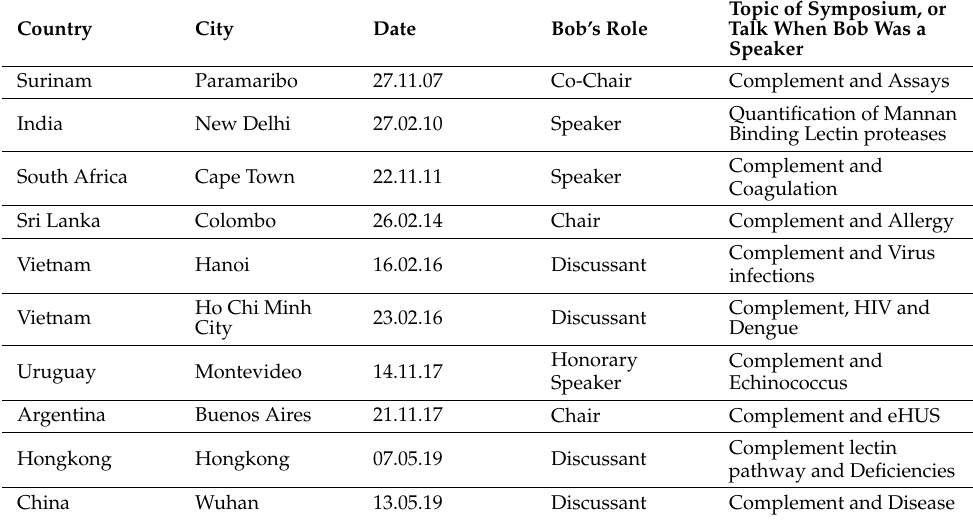
Figure 1. The EU complement consortium (picture taken at the teaching and research symposium in New Delhi, 27.02.10), from left to right, Yngve Sommarin (Lund), Franco Tedesco (Trieste), Jörgen Wieslander (Lund), Lennart Truedsson (Lund), Reinhard Würzner (Innsbruck), Narinda Mehra (AIIMS, New Delhi, host of symposium), Peter Garred (Copenhagen), Mac Turner (London), Moh Daha (Leiden), Bob Sim (Oxford), Tom Eirik Mollnes (Bodo), Krishana Gulla and a colleague, complementologists from Indore, and Michael Loos (Mainz), who also passed away too early. Already published in [2] with permission for re-use by Elsevier B.V., Amsterdam, The Netherlands (Ticket number 210512-012992).